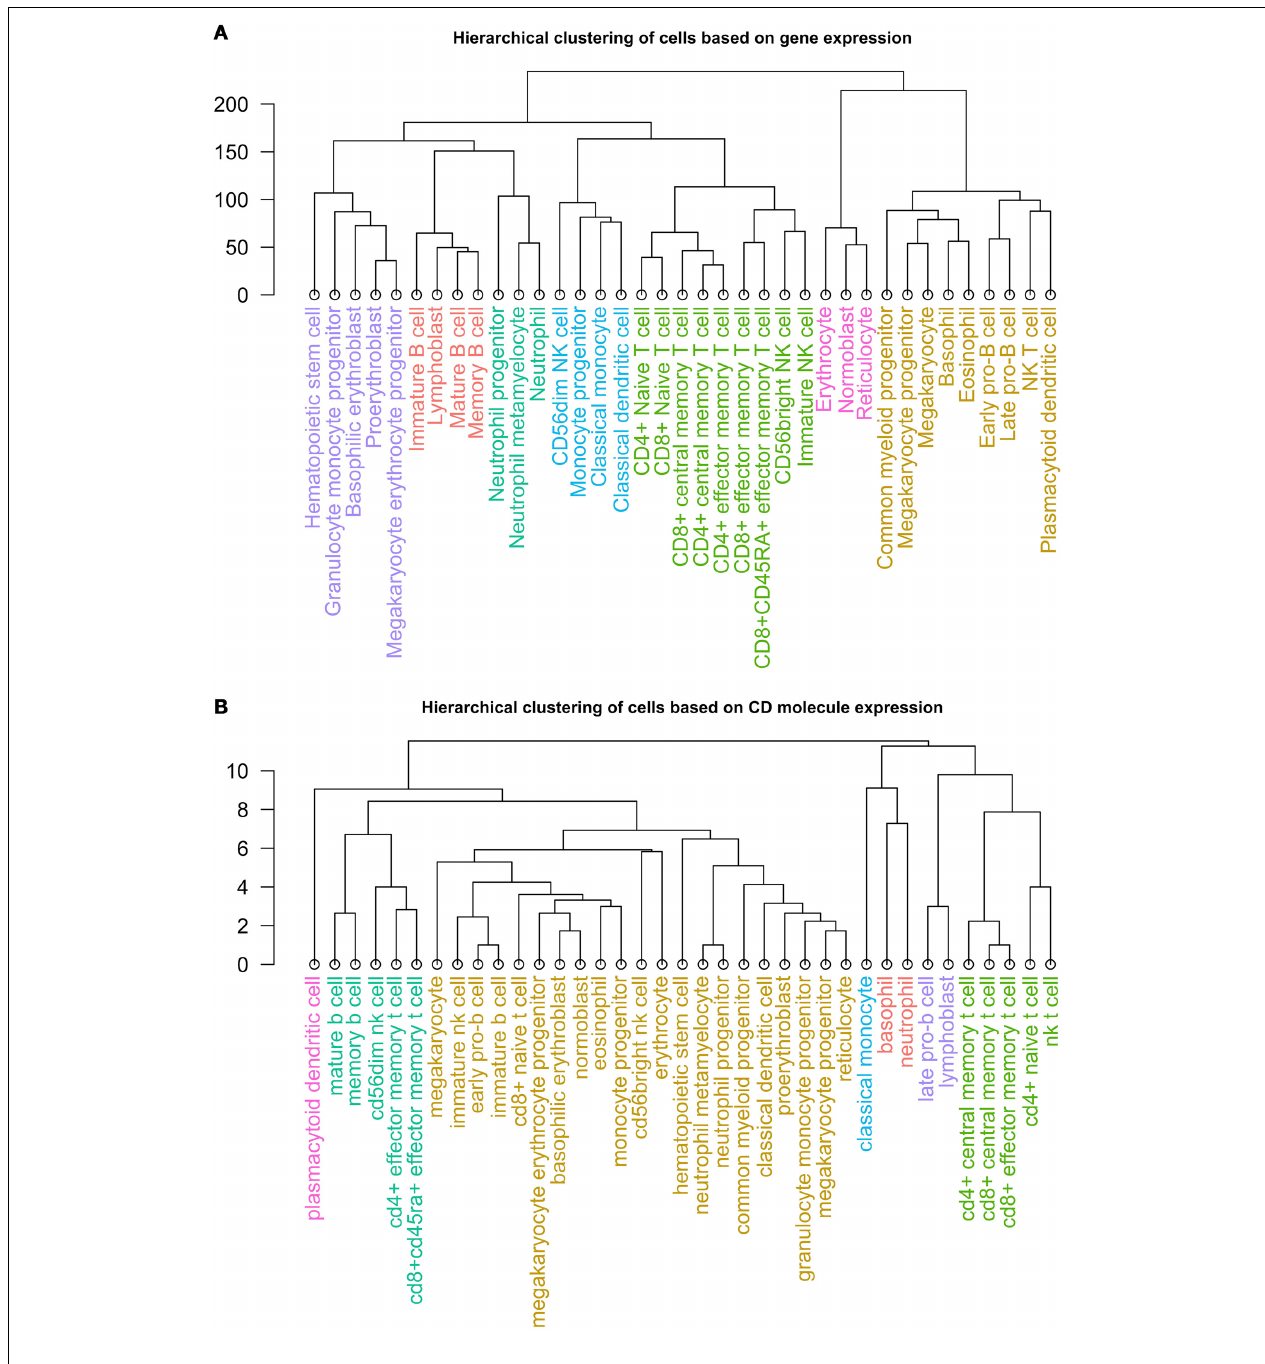
FIGURE 4 | Dendrogram of the clusters resulting from hierarchical clustering of 37 non-diseased hematopoietic cells by (A) expression of ∼ 35,000 mRNAs and (B) expression of 305 CD protein.